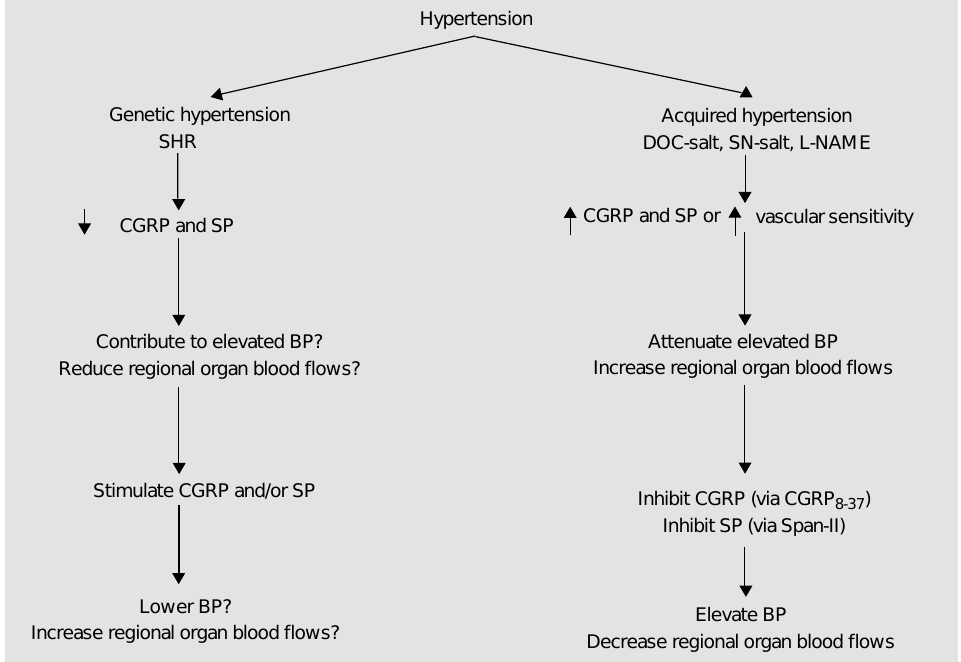
Figure 7. Proposed role(s) of calcitonin gene-related peptide (CGRP) and substance P (SP) in experimental hypertension. SHR: spontaneously hypertensive rats; BP: blood pressure; DOC-salt, SN-salt and L-NAME-induced hypertension: deoxycorticosterone, subtotal nephrectomy and N (cid:2) -nitro-L-arginine methyl ester, respectively; Span-II: SP receptor antagonist